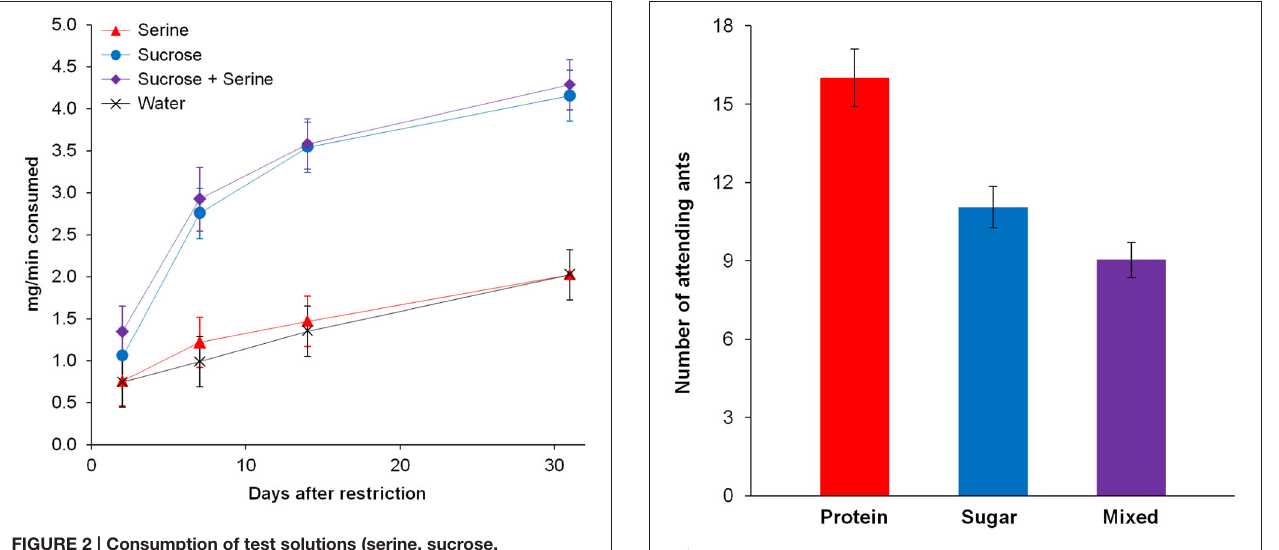
FIGURE 2 | Consumption of test solutions (serine, sucrose, sucrose + serine, water) by workers from colony fragments maintained on the protein diet, as a function of the time since the onset of the nutritional restriction. Estimated marginal means and 95% confidence intervals are given. TABLE 2 | Test statistics for the general linear model with the consumption of test solutions as dependent variable, for colony fragments on the protein diet.